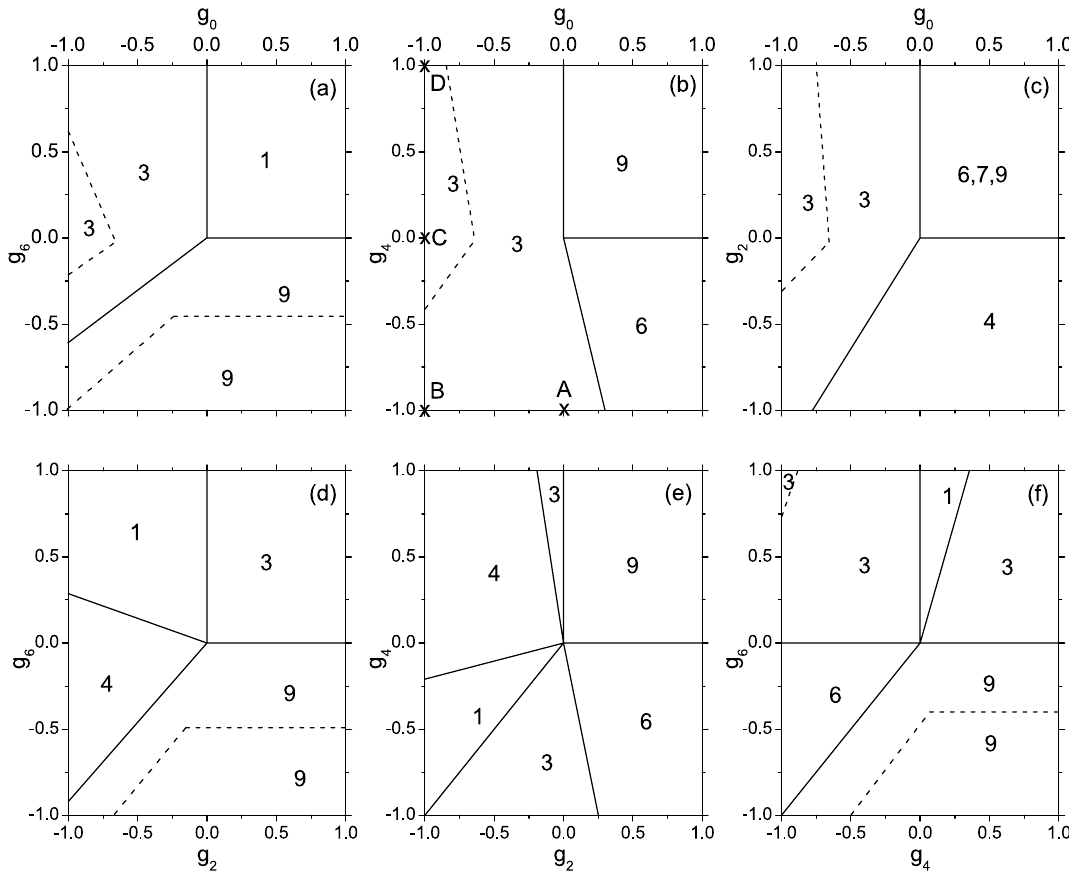
Figure 1. The phase-diagram of a 3-body trapped system with spin-3 cold atoms. In each panel two g η are chosen to serve as the ordinate and abscissa. The values of the other two g η are given at zero. The phase of the g.s. is specified by the total spin S marked inside the related zone. The district bound by the dotted lines has E gap ≥ 0.8